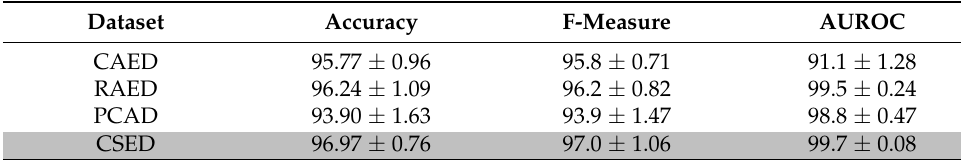
Table 6. Performance of RF (binary classification).